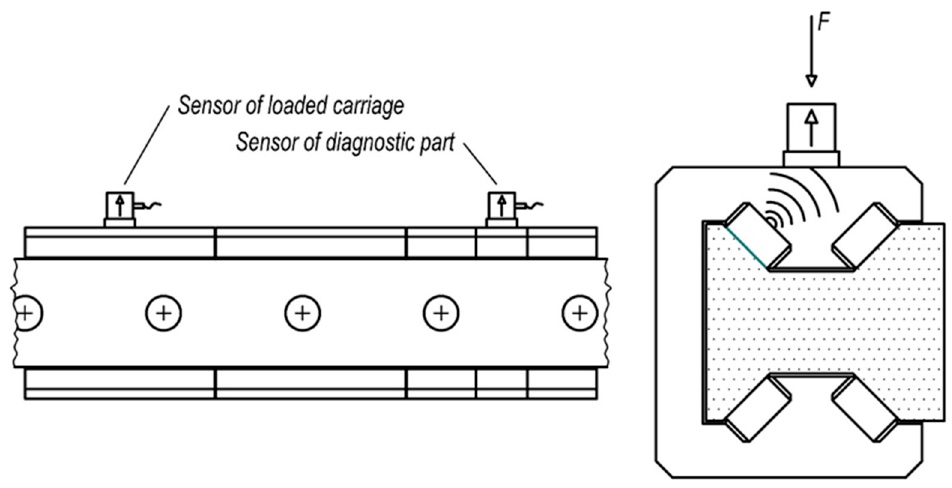
Figure 10. The scheme of sensor position against the damage.